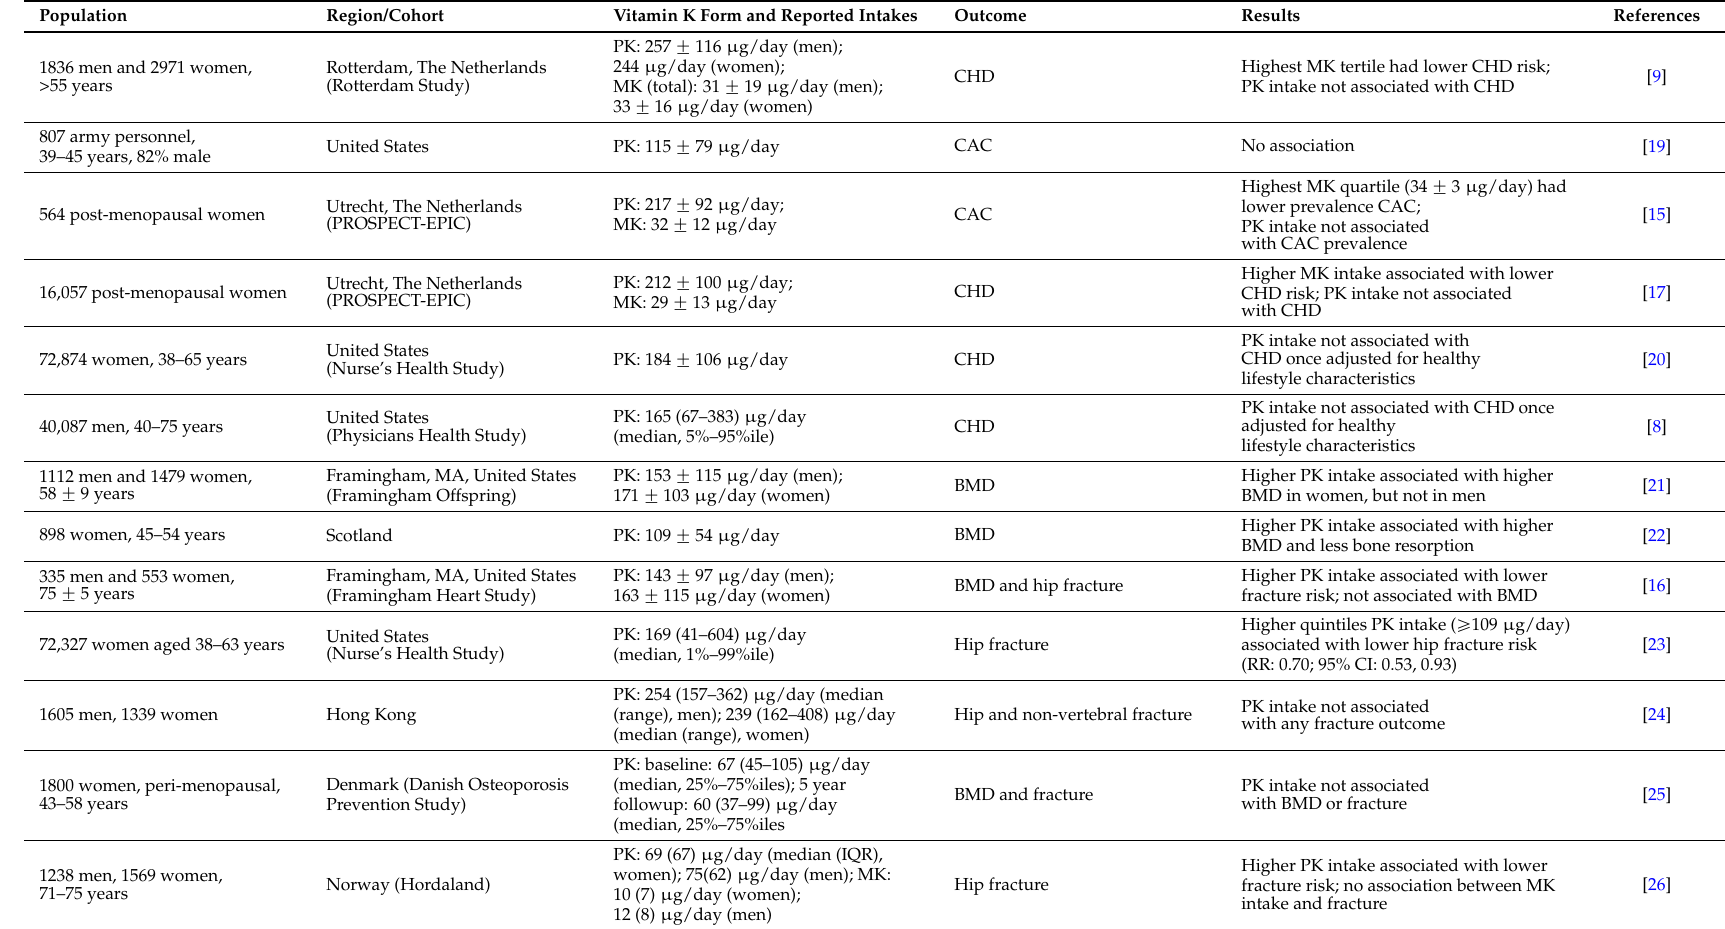
Table 1. Population-based studies of vitamin K intake and